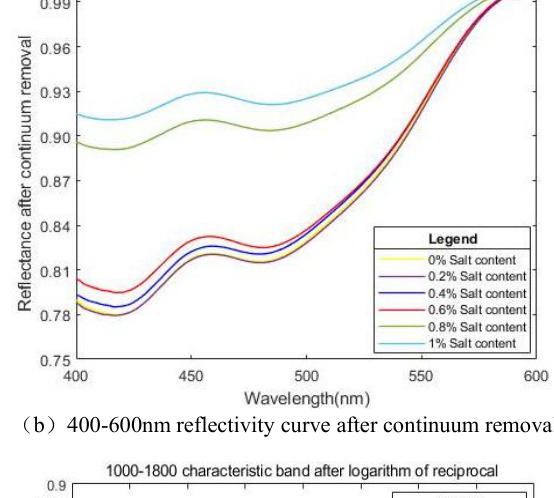
（ a ） Original spectrum 500-1500nm reflectance curve